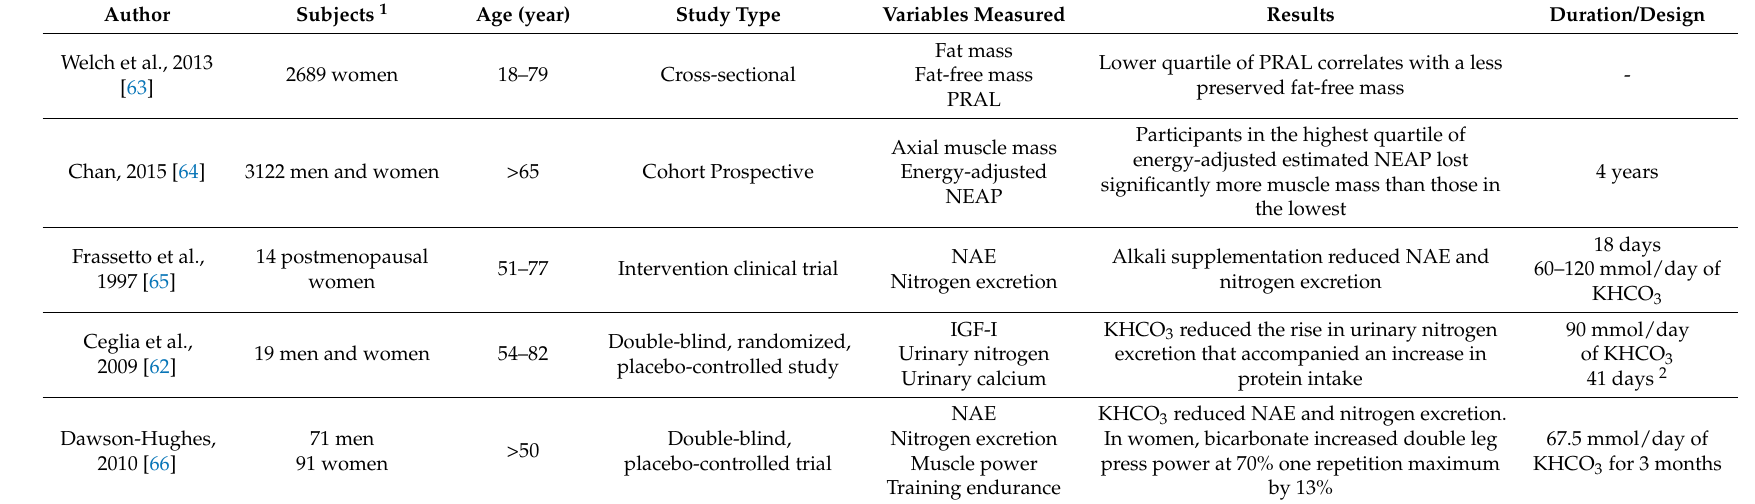
Table 2. Human studies showing the impact of metabolic acid load status on muscle